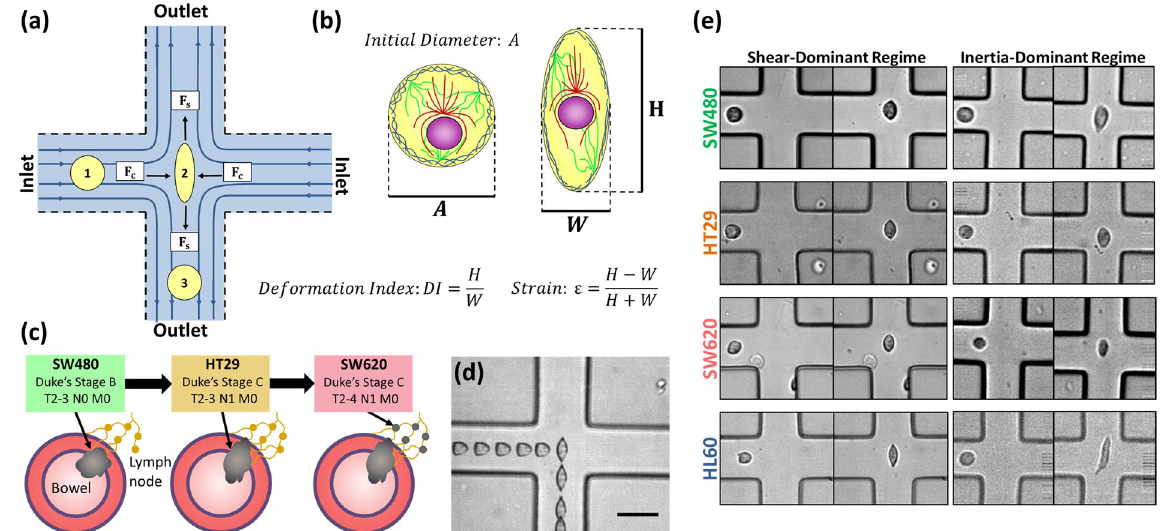
Figure 1. ( a ) Schematic of cross-flow region. ( b ) Schematic of a cell including the nucleus and cytoskeletal filaments (actin, microtubules and intermediate filaments) which are the main contributors of cell stiffness. Also included are parameters extracted from high speed videos of cell deformation: A is the initial diameter of the cell before it deforms, H is the height of the cell and W is the width of the cell. ( c ) Schematic describing the model for colorectal cancer progression using the three cell lines: SW480, HT29 and SW620. ( d ) Superimposed bright field images showing a single cell entering (from left) the stagnation point (SP) of an extensional flow device and exiting to the bottom of the chamber. ( e ) Example images of deformation events of SW480, HT29, SW620 and HL60 cell lines. Including an image before the cell is deformed and an image of deformation at the SP, for a shear-dominant and inertia-dominant-flow regime. Images from the shear-dominant regime were at a flow rate of Q = 50 µ l/min with suspension buffer viscosity of µ = 33 cP, and in the inertia dominant regime Q = 600 µ l/min and µ ≈ 1